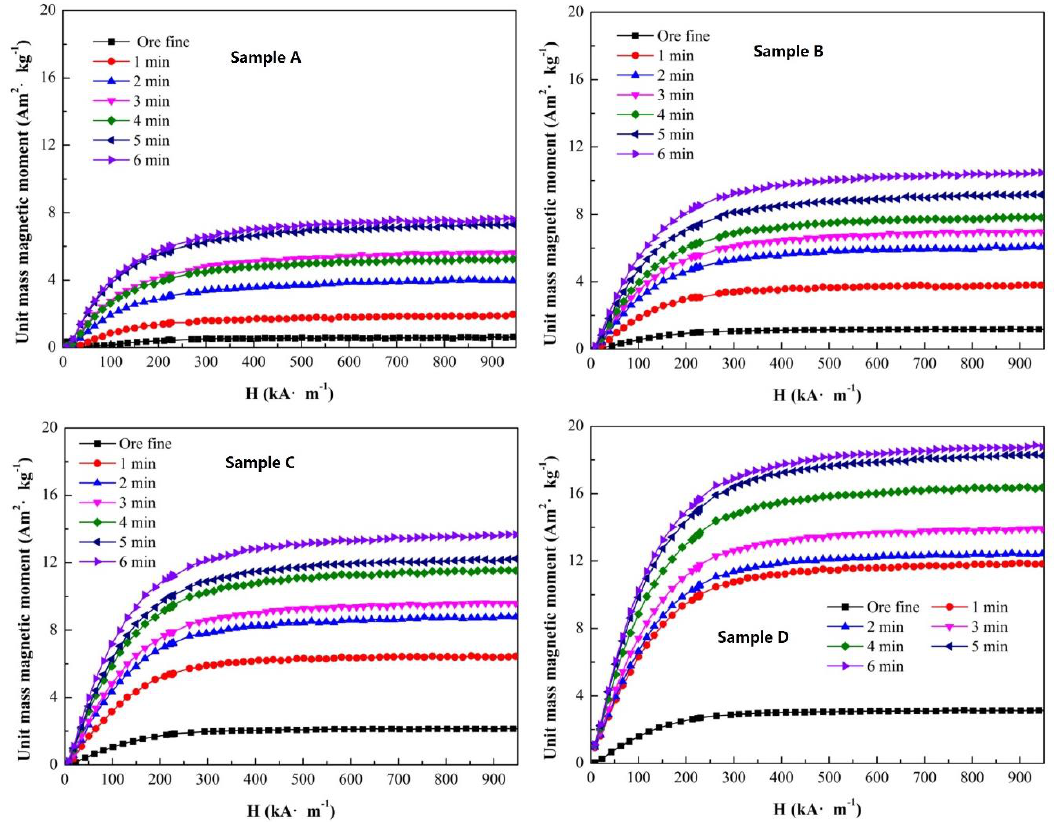
Figure 7. The unit mass magnetic moment of sample A to D with different roasting times.